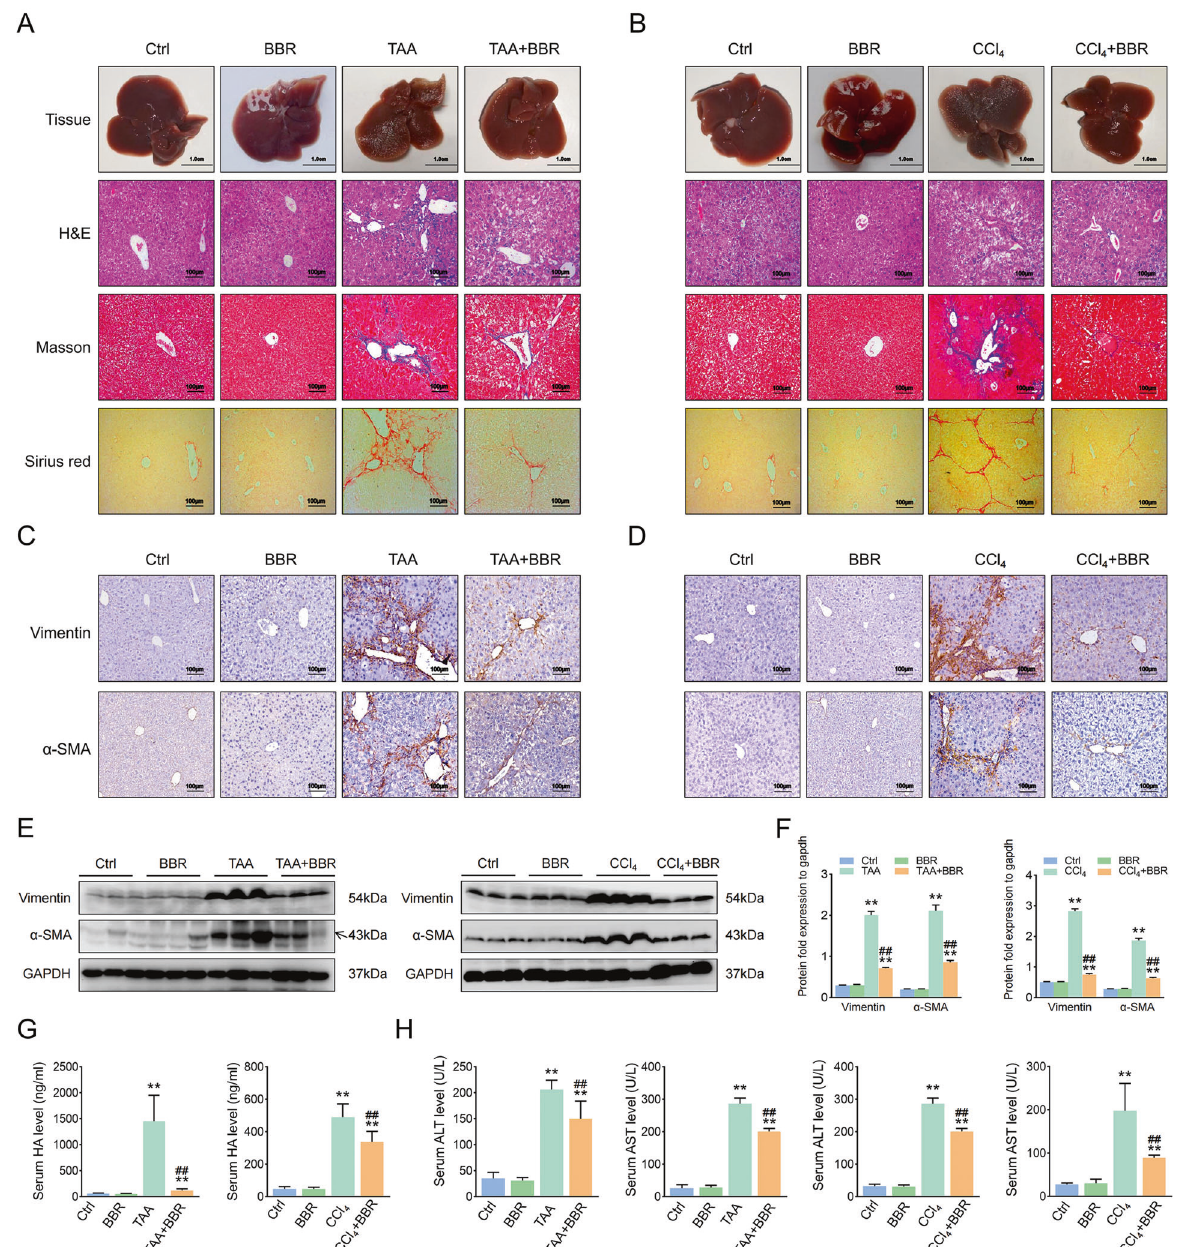
Fig. 1 BBR alleviates liver fi brosis in mice. Mice were divided into: Control group (Ctrl, only i.p. with saline or oil, respectively), Berberine group (BBR, BBR 200 mg/kg/day intragastrically and i.p. with saline or oil, respectively), Liver fi brosis model group (TAA or CCl 4 , TAA/CCl 4 - induced hepatic fi brotic, i.p. with TAA or CCl 4 , respectively), and TAA- or CCl 4 -treated group plus BBR (TAA + BBR or CCl 4 + BBR). A , B General examination of TAA/CCl 4 -induced mouse liver fi brosis by H&E, Masson ’ s trichrome, and Sirius red staining. C , D Vimentin and α -SMA are represented in TAA/CCl 4 -induced mouse liver fi brosis. E , F Protein expression of Vimentin and α -SMA in TAA/CCl 4 -induced mouse liver fi brosis. G Determination of serum hyaluronic acid. H Determination of serum ALT and AST. The results are expressed as mean ± SD. Data are representative of three independent experiments; n = 6 in every group; Scales: 1 cm or 100 μ m. Representative photographs are shown. Compared with the control group, ** P < 0.01; compared with the model group, ## P < 0.01. of ROS by augmented autophagy is expected to contribute to the BBR-mediated HSC ferroptosis and suppression of autophagy maintenance of cell stability. We found that BBR treatment enhanced BBR-induced HSC ferroptosis. enhanced 4-HNE expression in fi brotic scar regions in mouse liver fi brosis. However, BBR reduced ferric iron deposition and BBR downregulates autophagy to enhance ROS/ferrous- decreased FTH1 expression, re fl ecting a relationship between mediated HSC ferroptosis ROS and ferritin (Fig. 6A, B and Supplementary Fig. 7A, B). Then Impaired autophagy promotes the failure of protein and organelle impaired autophagy by BBR, CQ, or 3-MA markedly enhanced cell quality control and increases basal levels of ROS, which could lead ROS levels and triggered ferroptosis events. Western blot analysis to increased oxidative stress [12, 13, 16]. Therefore, the reduction Cell Death Discovery (2021)